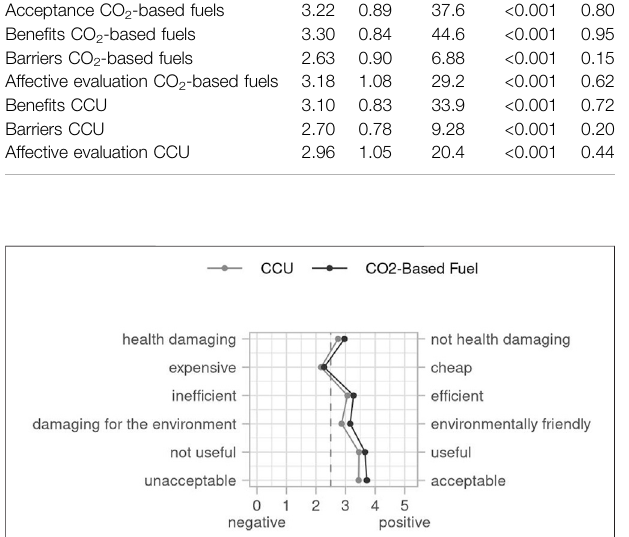
FIGURE 2 | Results of the affective evaluation of CCU and CO 2 -based fuels ( N (cid:1)